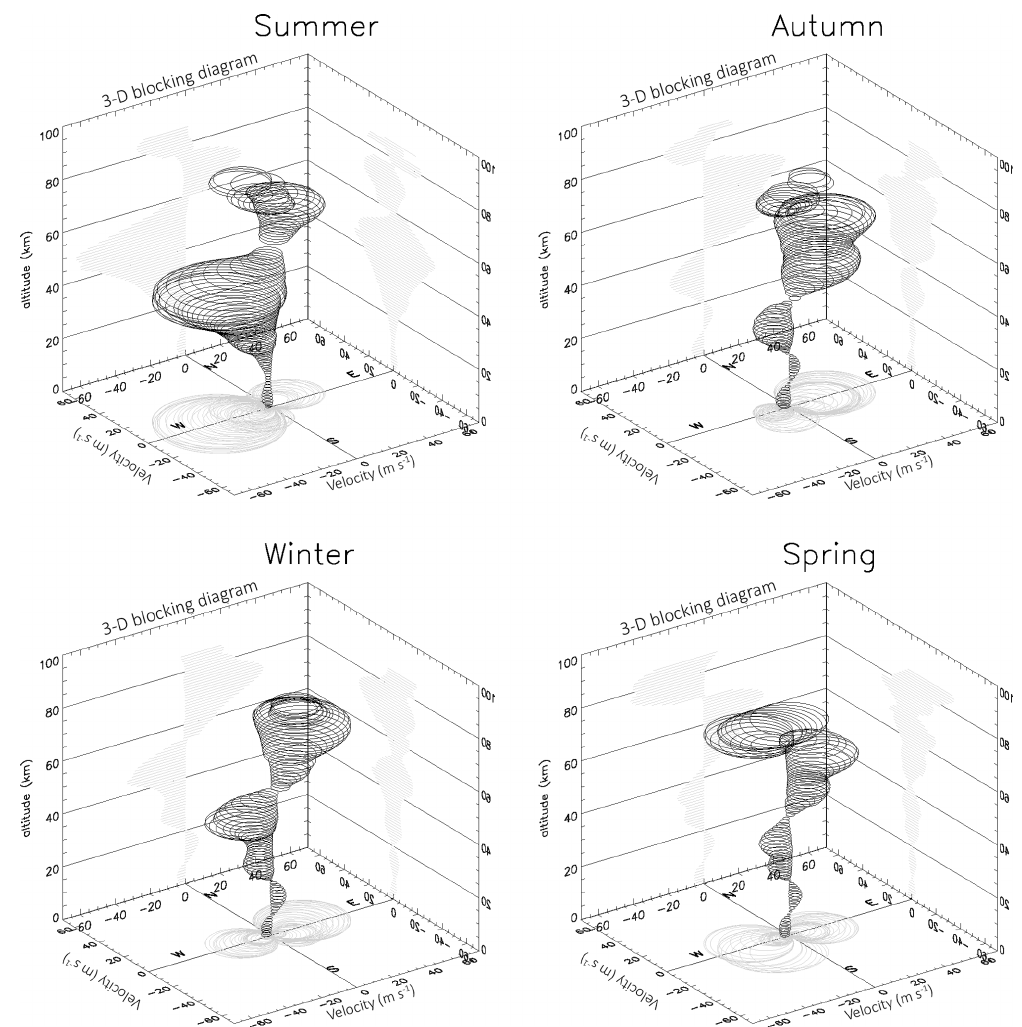
Figure 7. Three-dimensional blocking diagrams from 0 to 85km (critical level projections can be seen at the left and right planes of the 3-D blocking diagram) for summer, autumn, winter, and spring of 2009. The N–S (north–south) axis representing the meridional wind velocity, and E–W (east–west) is the zonal wind velocities derived from the HWM-07 and the vertical axis is the